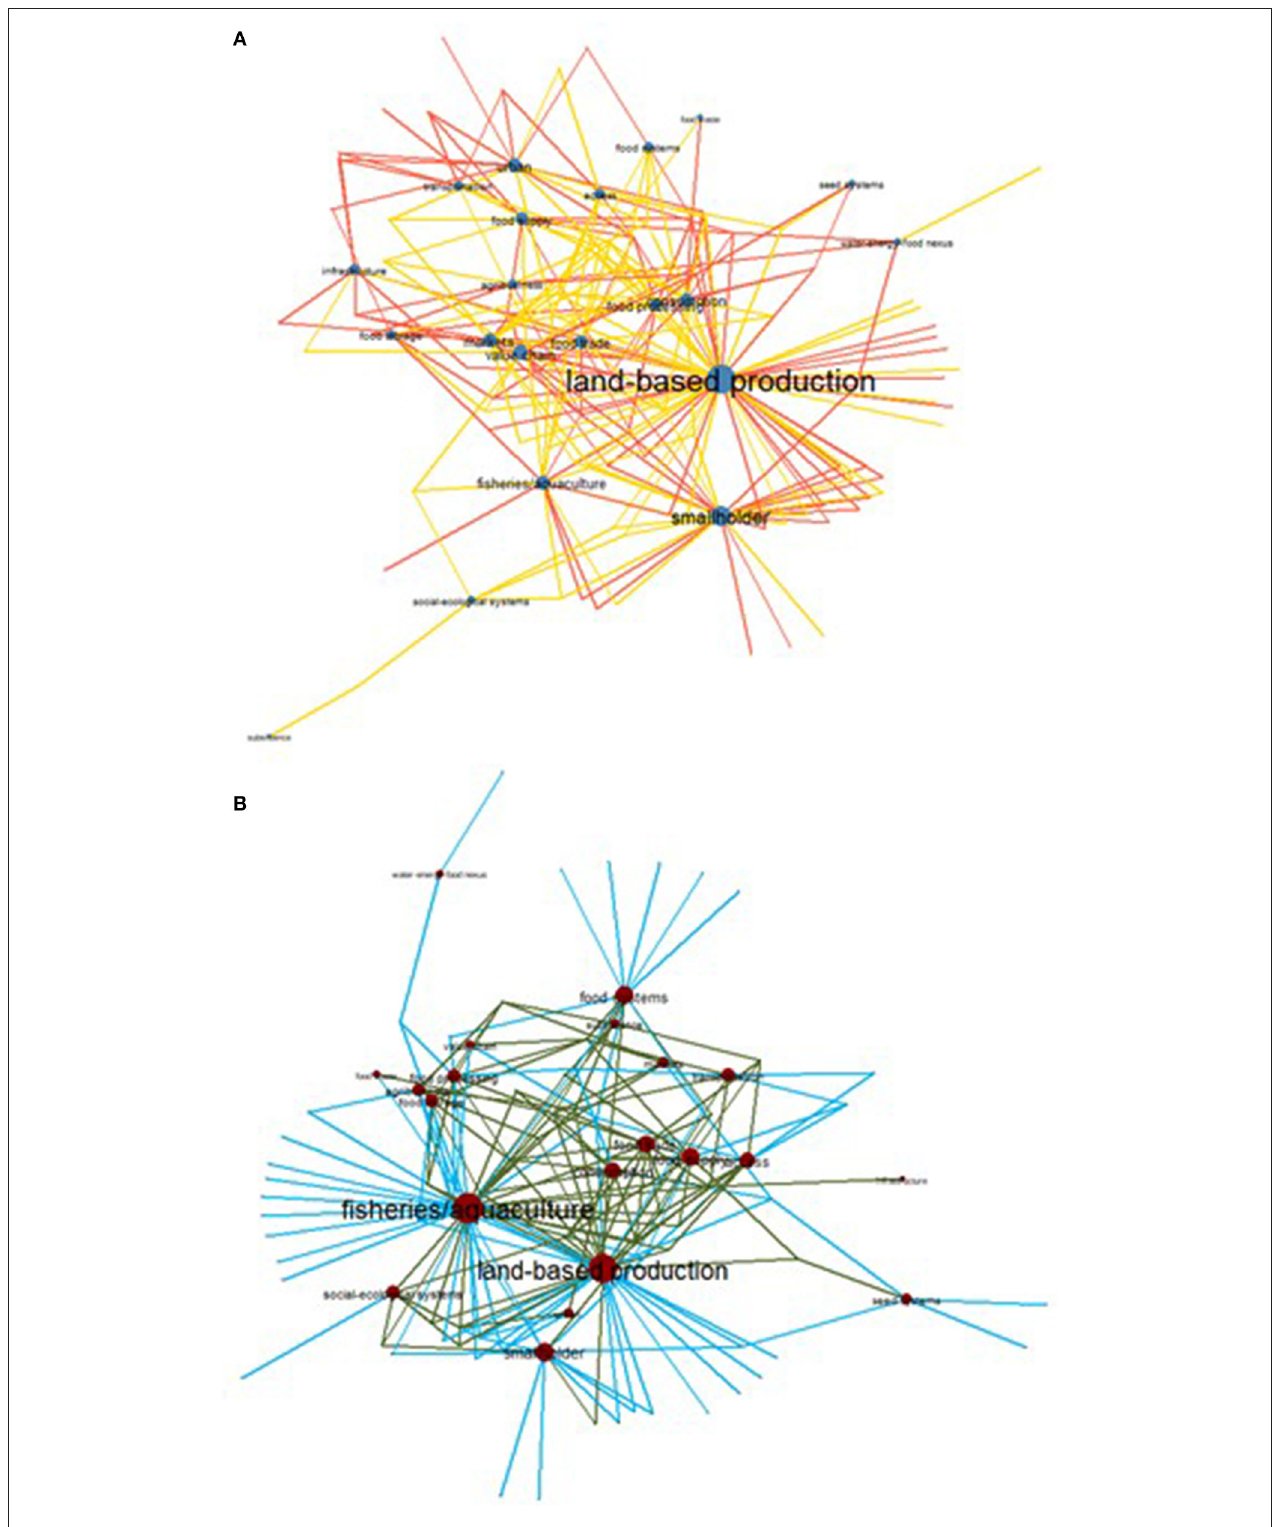
FIGURE 2 | Food systems definition codes used in (A) Southeast Asian projects/initiatives (red) and research studies (yellow), and (B) PICTS projects/initiatives (blue) and research studies (green). Chart shows degree centrality scores based on networks disaggregated by region.